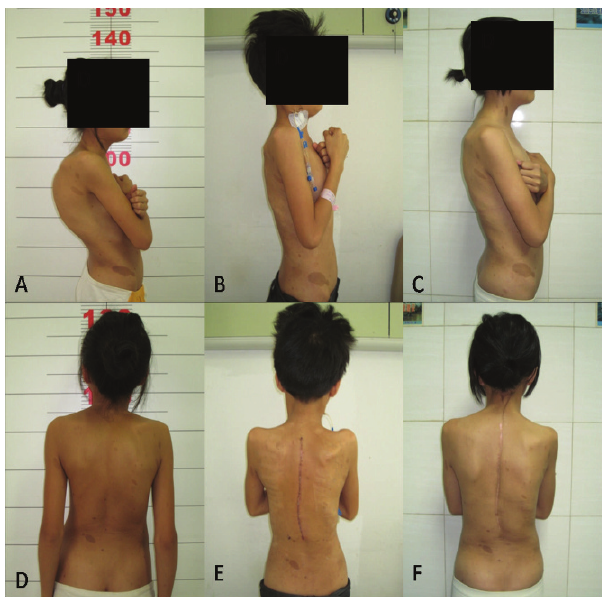
Figure 4 - Pre-operative, immediately post-operative and 24 month post-operative photos of patient postures. A and D) The preoperative anterior and posterior(AP) views and lateral view showed multiple cafe au lait spots on the patient’s skin and significant hyperkyphosis posture; B and E) The immediate post- operative AP and lateral view showed significant improvement of postures; C and F) 24 month post-operative AP and lateral view showed well-maintained body posture in both views; the incision